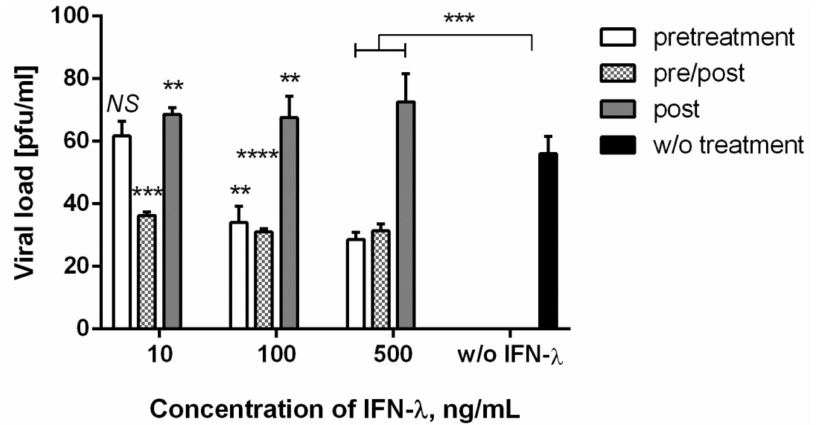
Figure 4. Inhibition of CHIKV replication in different IFN- λ 1 treatment regimes . Vero cells were used. Virus was harvested at 24 hpi, and titers were determined by plaque assay. p value significance levels were determined for cells treated with each IFN- λ 1 concentration, compared to untreated cells, by two-way ANOVA, followed by the pairwise Dunnett’s multiple comparisons test: ****—Adjusted p value < 0.0001; ***—<0.001; **—<0.01; NS—no significant differences. Data are represented as mean ±